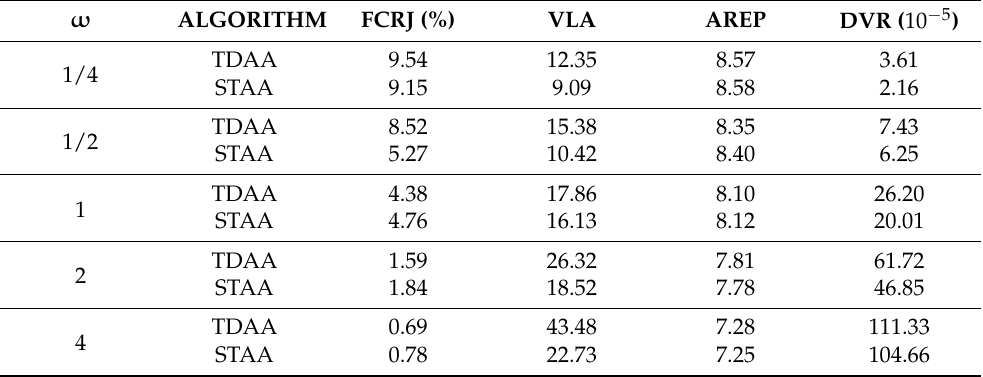
Figure 9. Schematic diagram comparing the numerical fluctuation frequency in the DSI under 𝜔 ≤ 1 : ( a ) 𝜔 = 1 4⁄ ; ( b ) 𝜔 = 1 2⁄ ; ( c ) 𝜔 = 1 (red represents the STAA and blue represents the TDAA [11]).